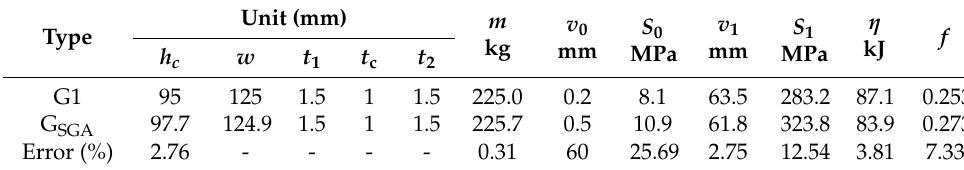
Table 7. Error between the optimal algorithm and